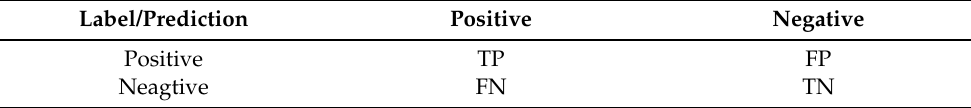
Table 5. Matrix of classification metrics.